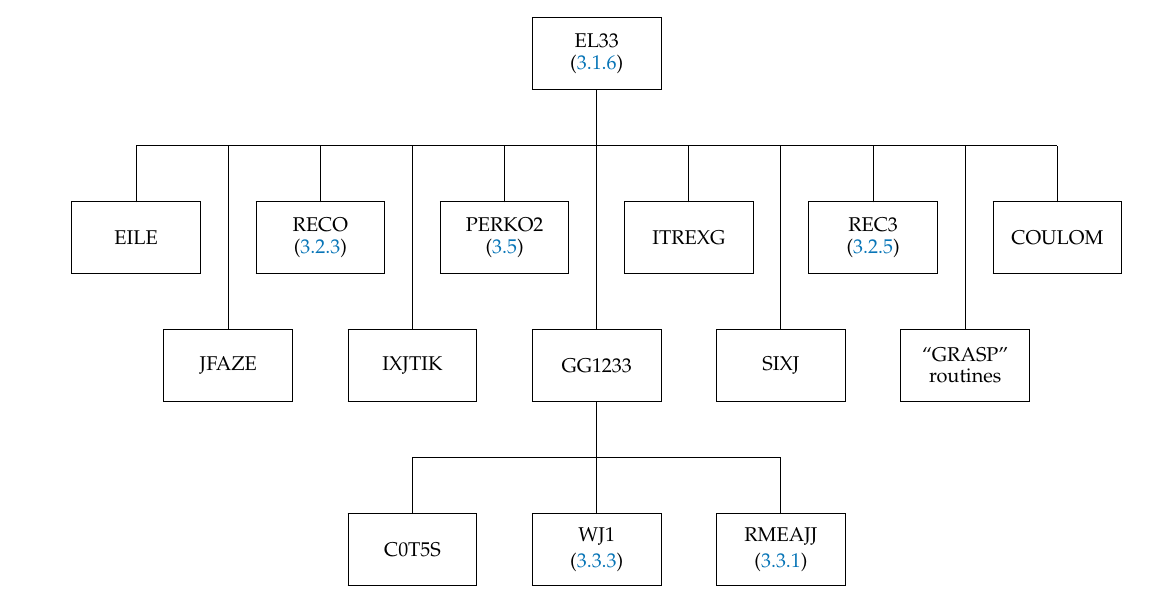
Figure 7. Structure of the subroutine EL33 . The box “GRASP” routines correspond to the routines ITRIG , SNRC , CXK , SPEAK , and TALK from the GRASP92 package